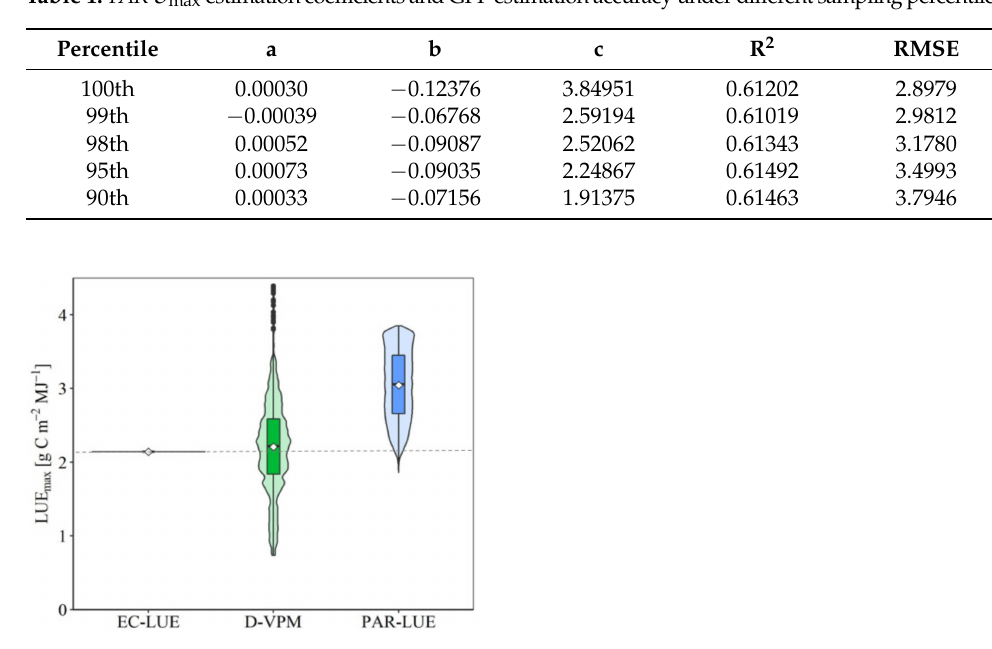
Figure 3. Variation range comparison of three daily E max at all selected flux sites. (The top and bottom edges of the box are the 75% and 25% quartiles, respectively; the short horizontal line and the small square in the middle of the box are the median and mean, respectively; the shape of the violin displays frequencies of values.)